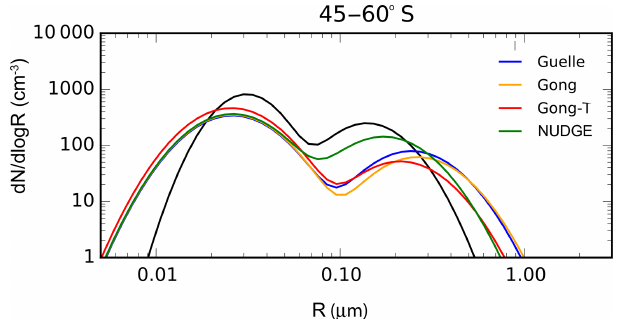
Figure 25. Size distribution of simulated and measured aerosol number concentrations in the marine boundary layer for the region 40–60 ◦ S (as in Fig. 10) for the year